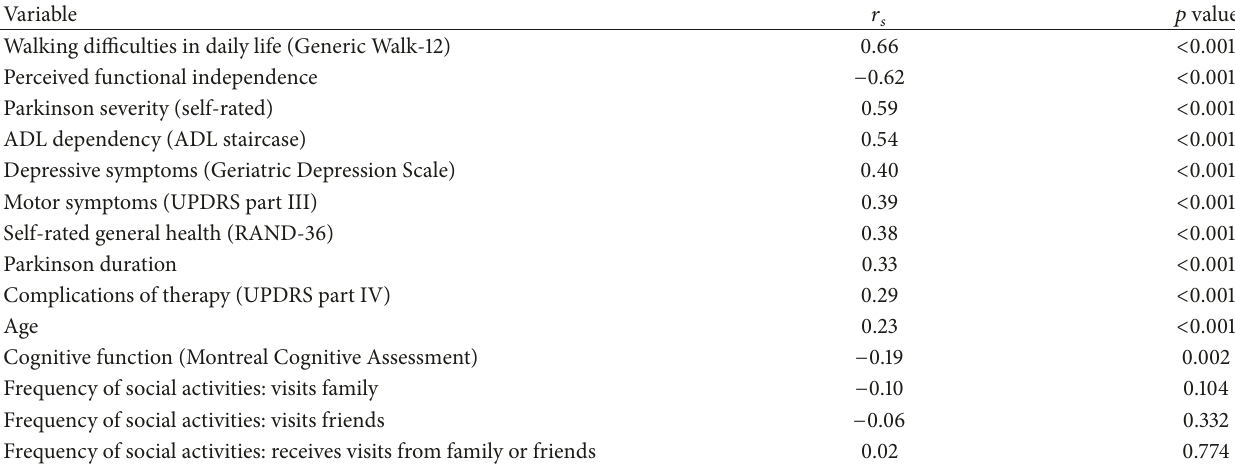
Table 3: Spearman correlations ( 𝑟 𝑠 ) between Parkinson’s disease Activities of Daily Living Scale (PADLS) scores and other variables. Variable 𝑟 𝑠 𝑝 value Walking difficulties in daily life (Generic Walk-12) Perceived functional independence